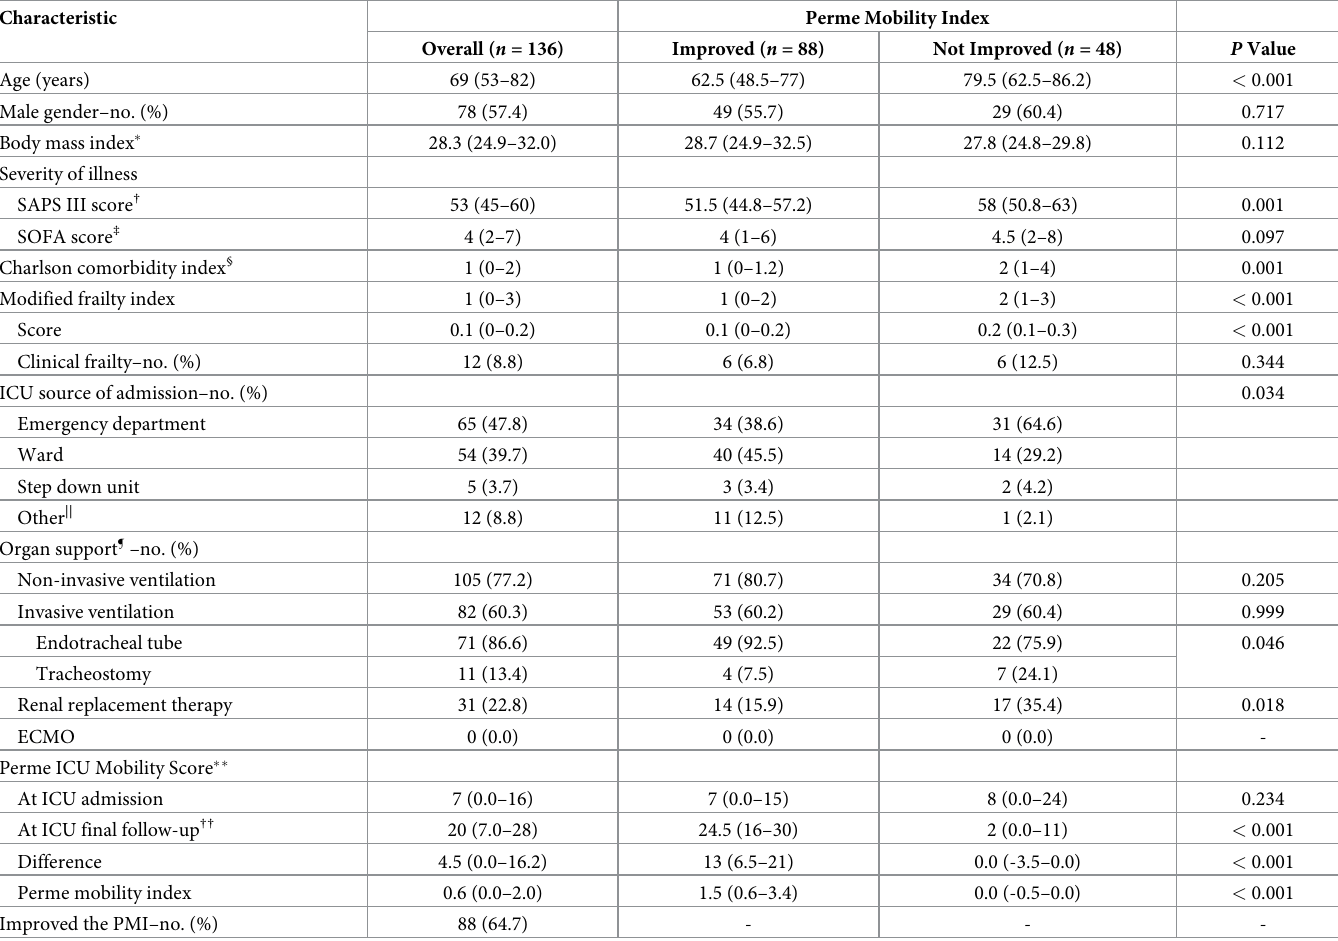
Table 1. Baseline characteristics of the included